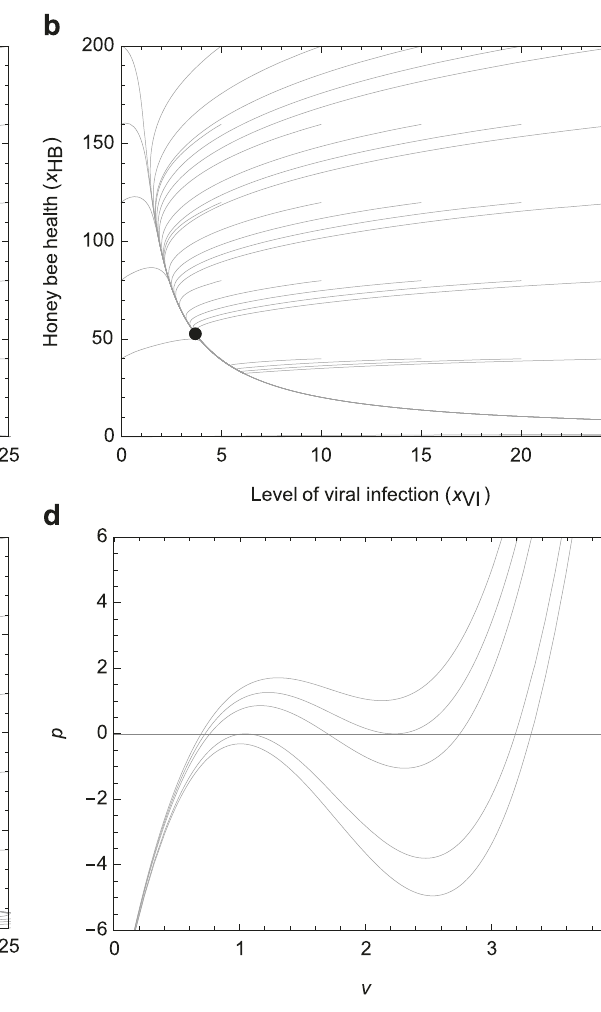
case of a high level of parasites. c Orbits and the three equilibria with immune- suppression; two orbits exiting from close initial conditions are marked with thick lines. d Equilibria of the subsystem of bee and virus for increasing immune- suppression. p isafunctionofthelevelofviralinfection v thatvanishesatequilibria; top curve: at low immune-suppression there is one equilibrium at high bee health; bottom curve: at high immune-suppression there is one equilibrium at low bee health; intermediate values of immune-suppression can cause three